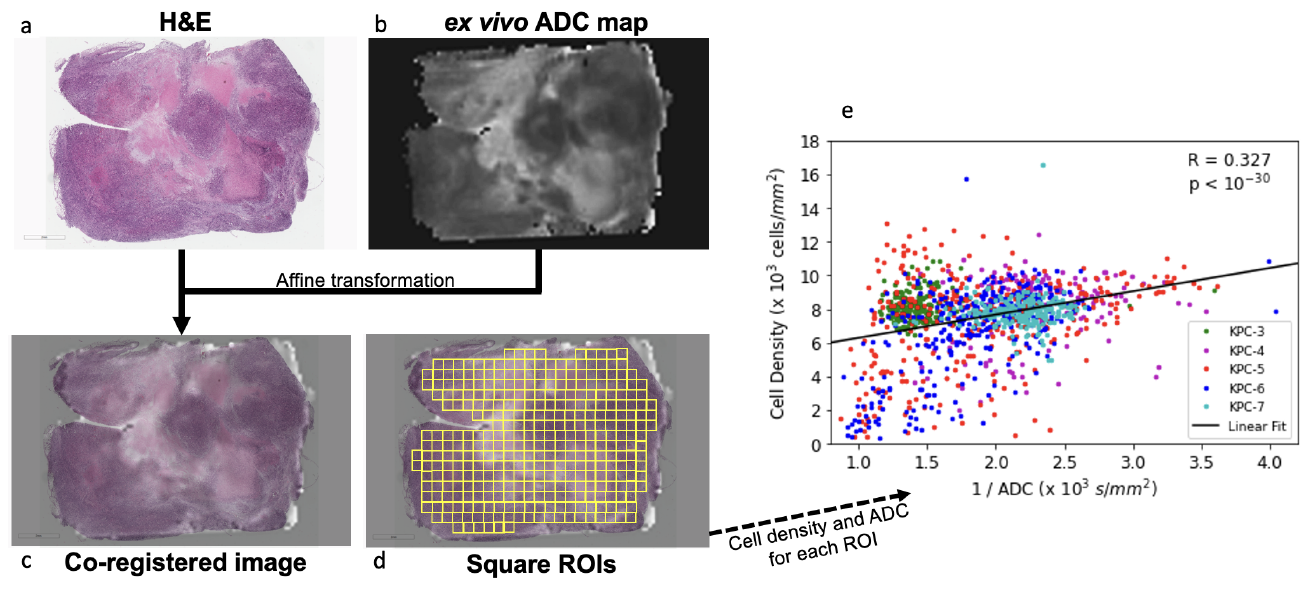
Figure 3. Correlation between ADC and cell density in KPC model. ( a ) H&E stained section and ( b ) ex vivo ADC map were transformed to the same space via affine transformation to produce a ( c ) coregistered image. ( d ) Square ROIs were placed covering the entire section show a negative correlation ( e ) between ADC and cell density ( R = − 0.38, p = 1.6 × 10 − 43